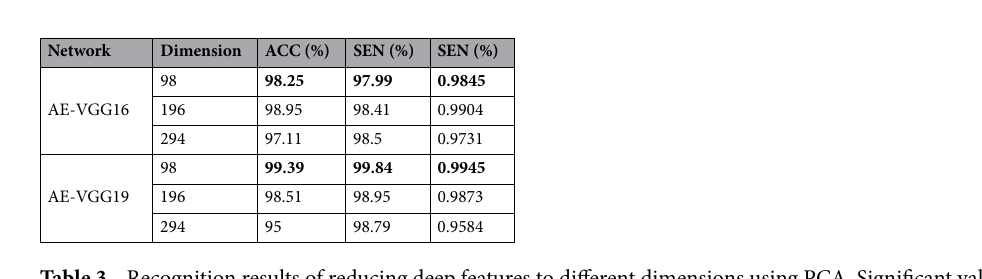
Table 3. Recognition results of reducing deep features to different dimensions using PCA. Significant values are in bold.